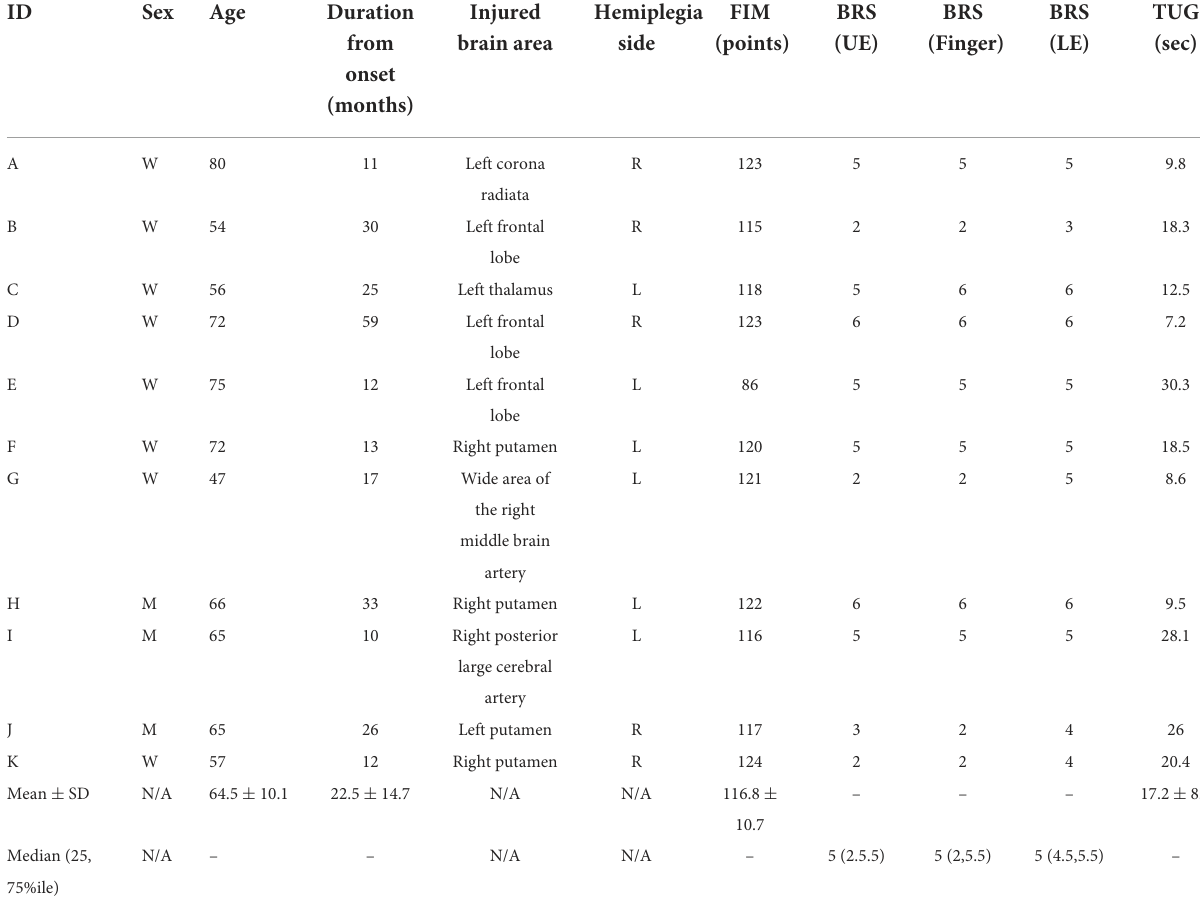
TABLE 1 Basic and clinical characteristics of the study participants at the time of initial assessments ( n = 11).